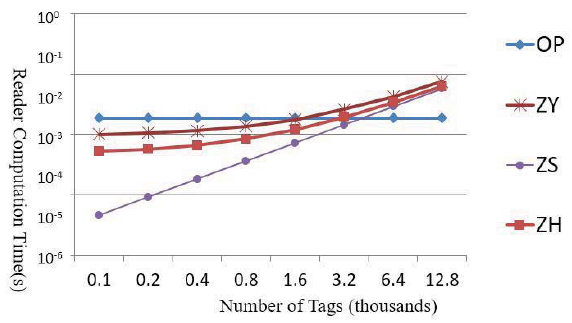
Figure 8. Comparisons of computation loads of